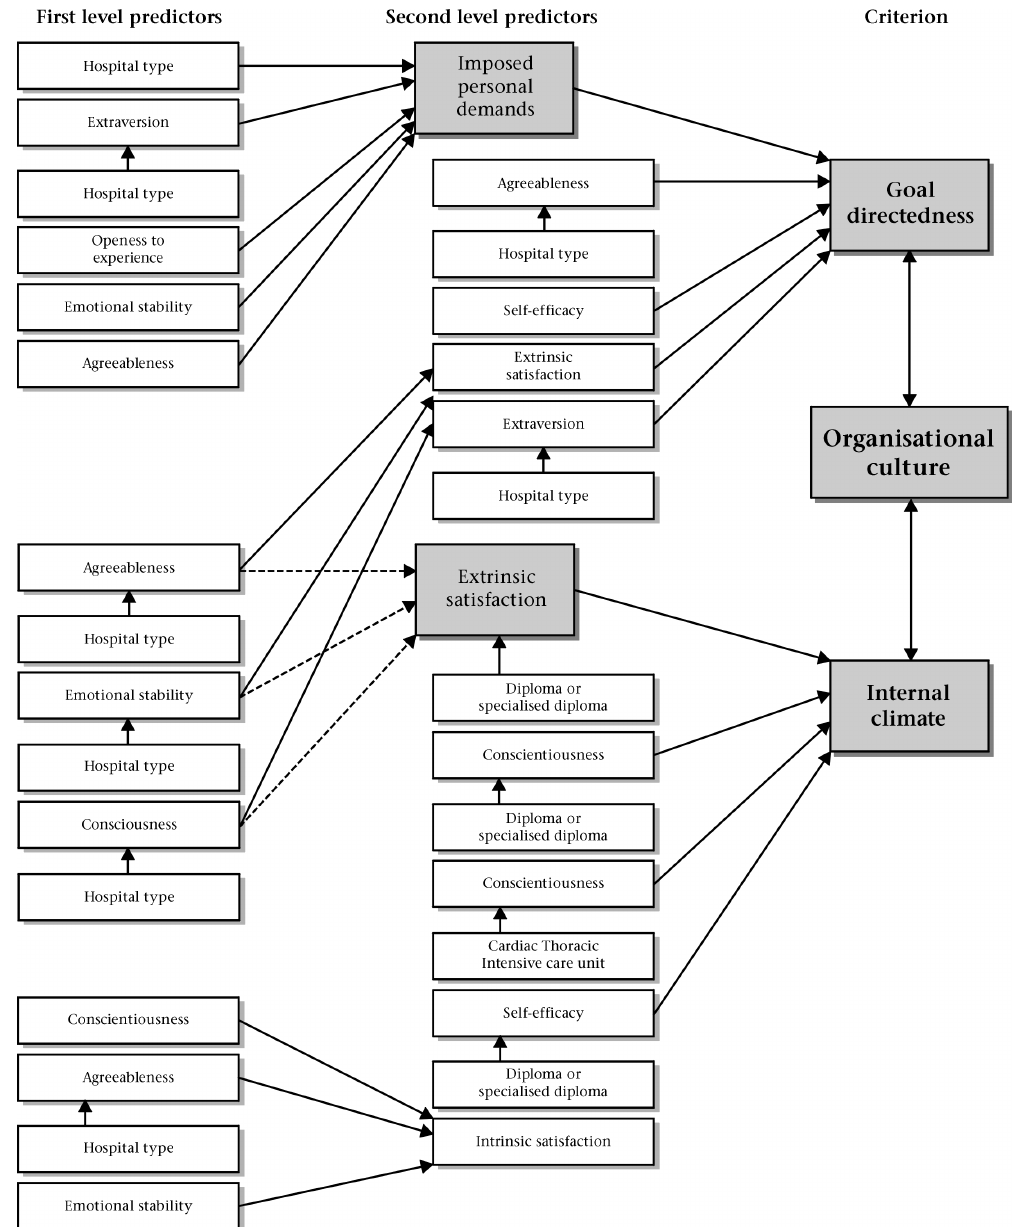
Figure 12: Composite empirical model for predicting subjective organisational